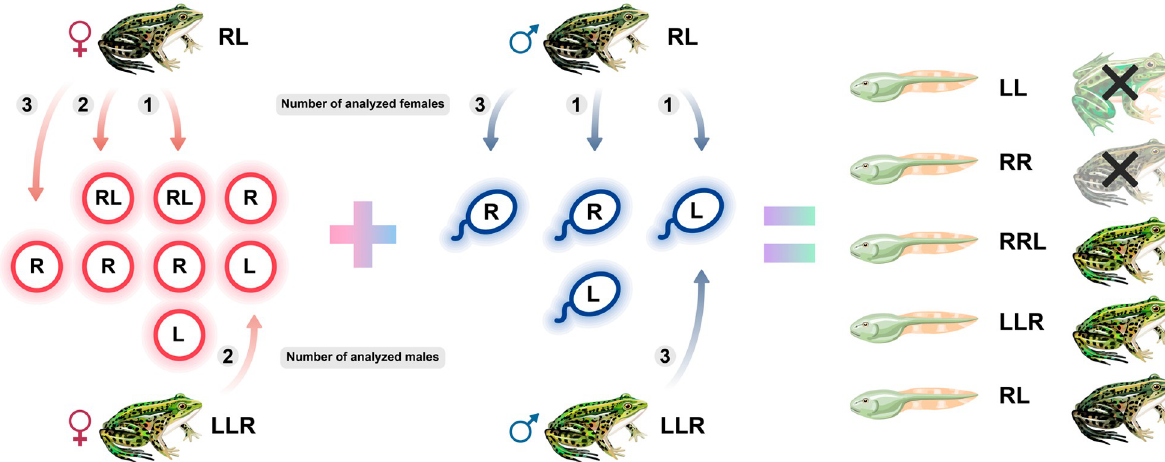
Fig 4. Schematic overview of contribution of diploid and triploid water frog hybrids to the maintenance of pure hybrid systems. Data from both the studied pure hybrid systems are summarised with the indication of genotypes, sex, and gametes of hybrid frogs, tadpole genotypes, as well as presumptive adult progeny. Female gametes are indicated in pink, and male gametes are indicated in blue. Gametes produced by RRL individuals were not included in the schematic because of the low number of investigated individuals.